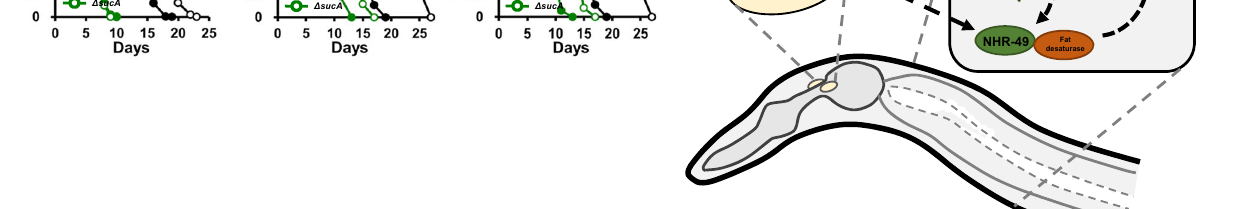
Fig. 7 | GR diets promote membrane fl uidity. a FRAP analysis showing that GR diets enhance the membrane fl uidity. Intestinal membrane fl uidity is measured using control animals expressing membrane incorporated GFP (QC114). Average T half values (the time when half of maximum recovery is reached) are presented. Error bars indicate SEM. Results from representative experiments are shown with additional repeats ( n ≥ 9 for each condition). See also Supplementary Movie